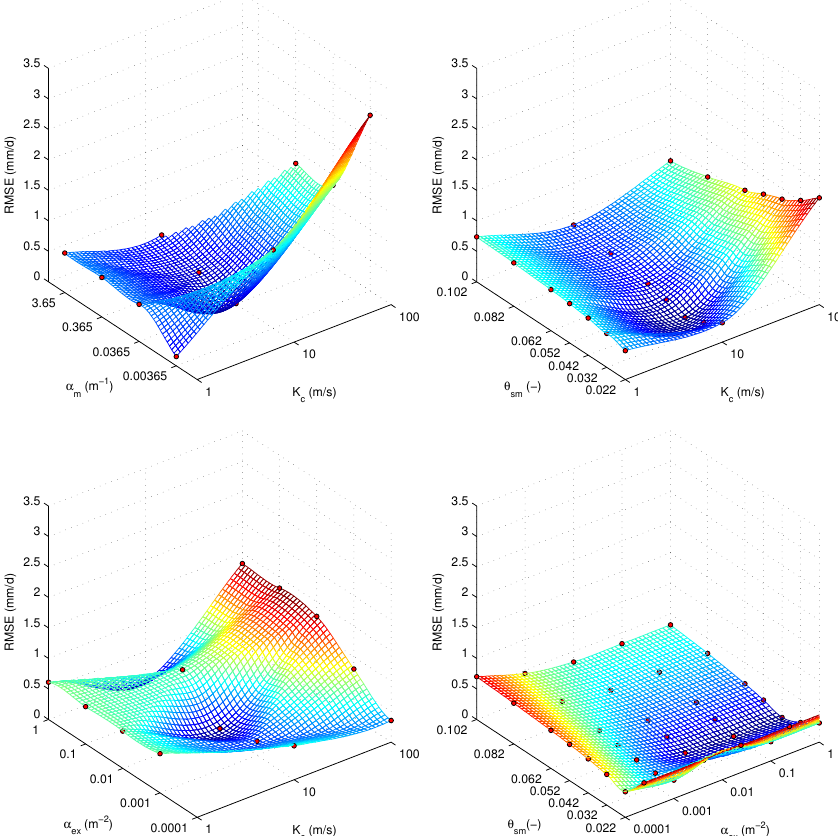
Fig. 10. Sensitivity matrices showing nonlinear inter-parameter